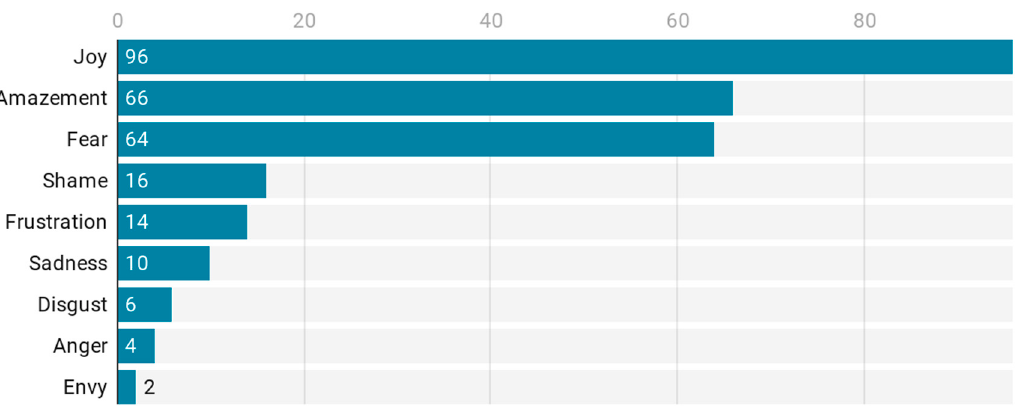
Figure 1. Emotional expressions.